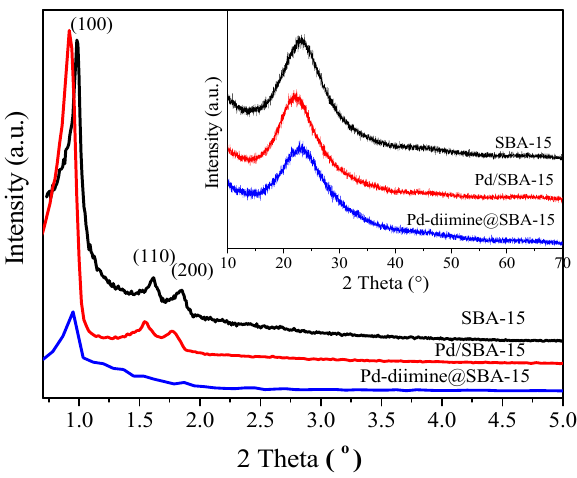
Figure 5. Small ‐ angle X ‐ ray diffraction (SA ‐ XRD) and XRD patterns of SBA ‐ 15, Pd/SBA ‐ 15, and Pd ‐ diimine@SBA ‐ 15.